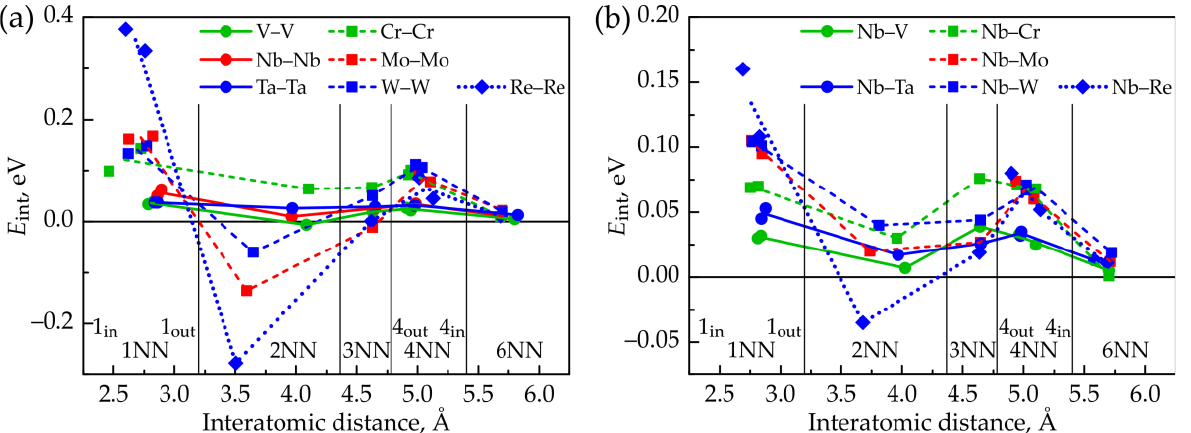
Figure 7. Interaction energy in pairs of identical ( a ) and different ( b ) impurity atoms depending on their interatomic distance. The polygonal chains are given according to the average values of energies and distances for each coordination ellipsoid.